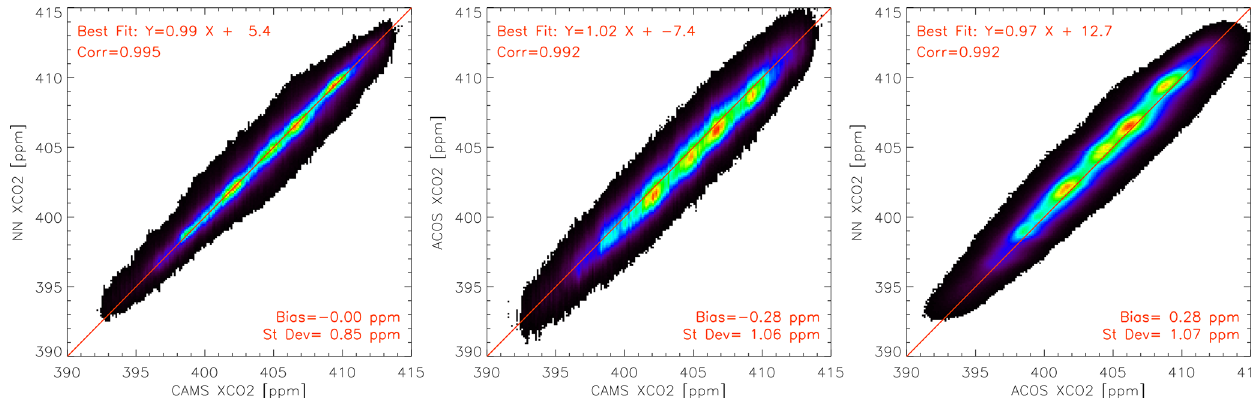
Figure 5. Inter-comparison of XCO 2 estimated from CAMS, ACOS, and the NN. The density histogram is based on nadir observations from February 2015 to December 2019. A similar figure for the glint cases is shown in Fig. A3.